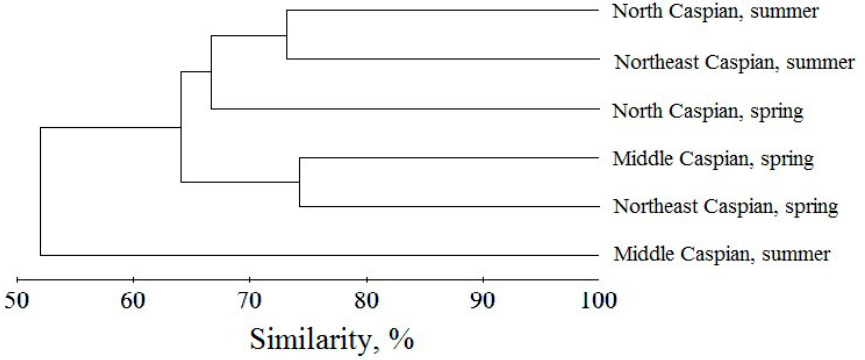
Figure 3. Dendrogram of the similarity of the species composition of zooplankton communities in the surveyed waters of the Caspian Sea.